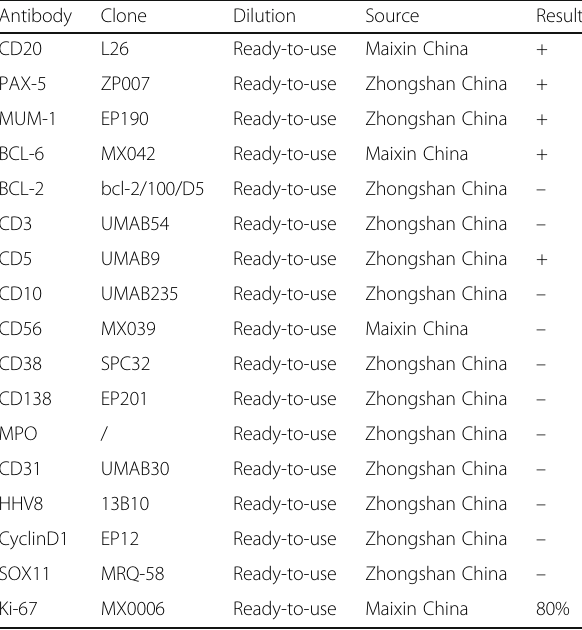
Table 1 List of antibodies Antibody Clone Dilution Source